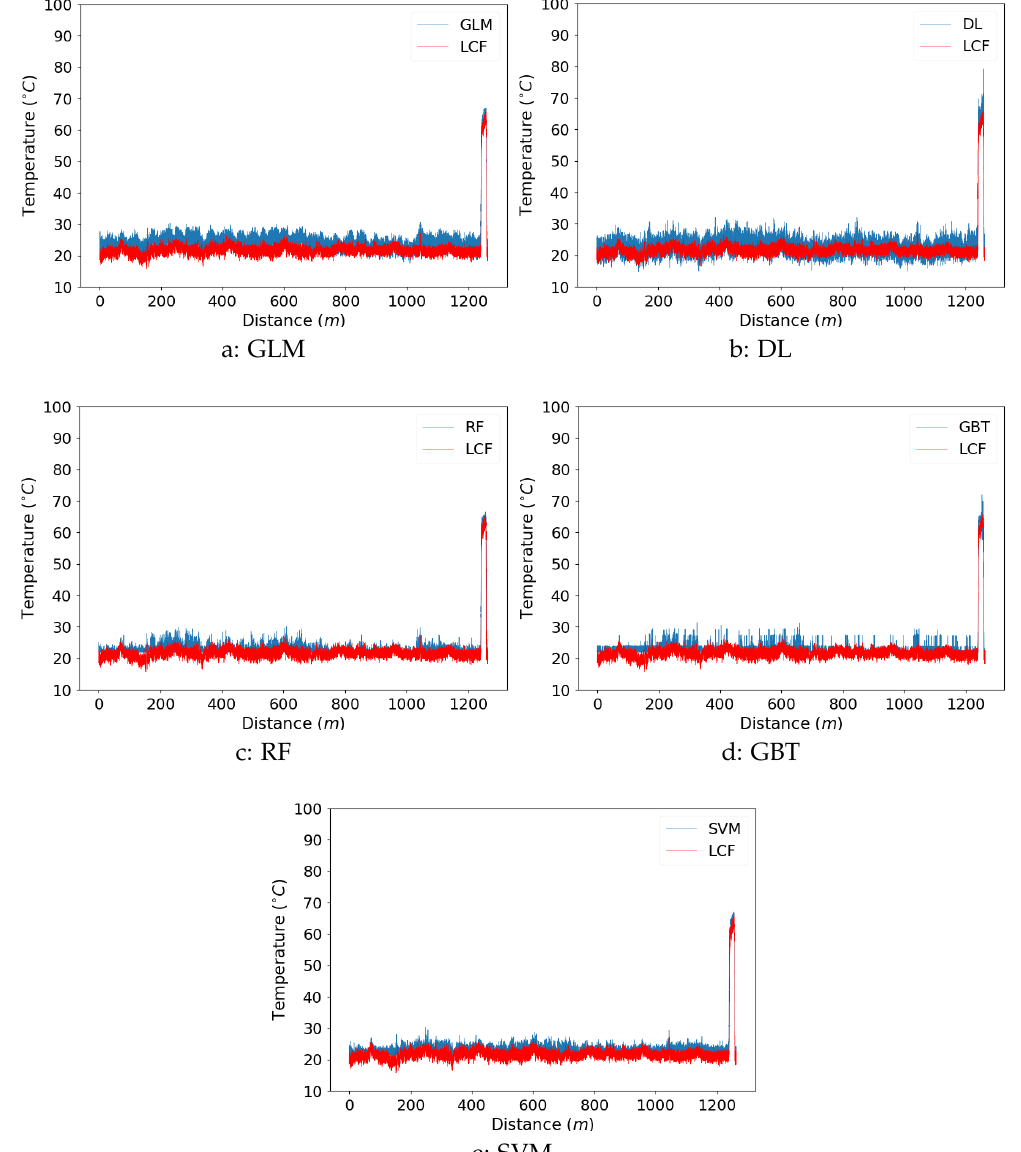
Figure 5. Temperature distribution along the fiber (65 ◦ C